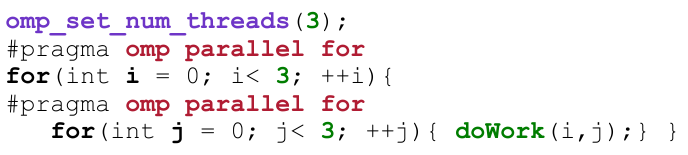
Fig. 1. Example illustrating the use of nested parallel blocks with each block using OpenMP for constructs. In the example, the function doWork will be called 9 times which means there is the possibility for 9 concurrently running calls to the function.